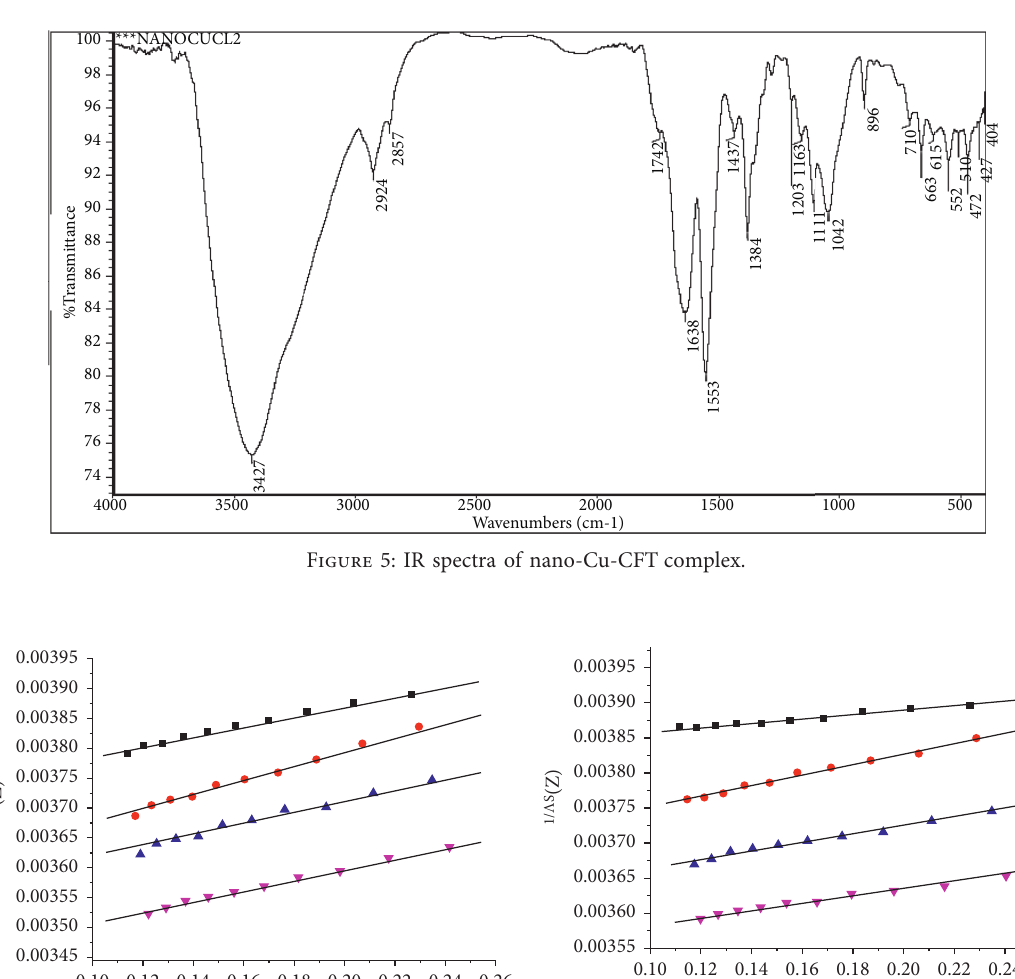
C Λ c 2 S ( z ) for (a) bulk CuCl 2 ( z ) with ±